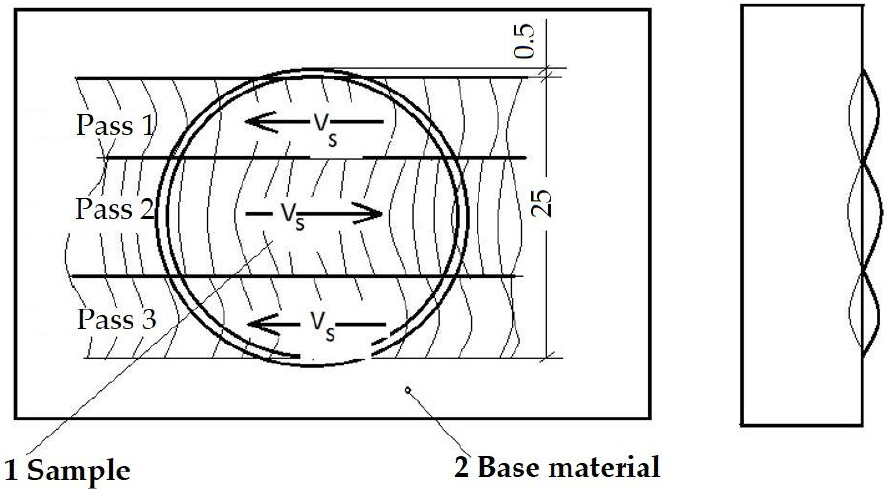
Figure 5. Details of the surface TIG remelting process.